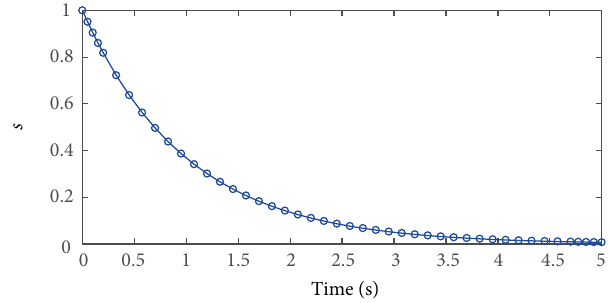
Figure 1: The first-order system ̇푠 = −훼푠 . The original state of 𝑠 is 1 and converges to 0